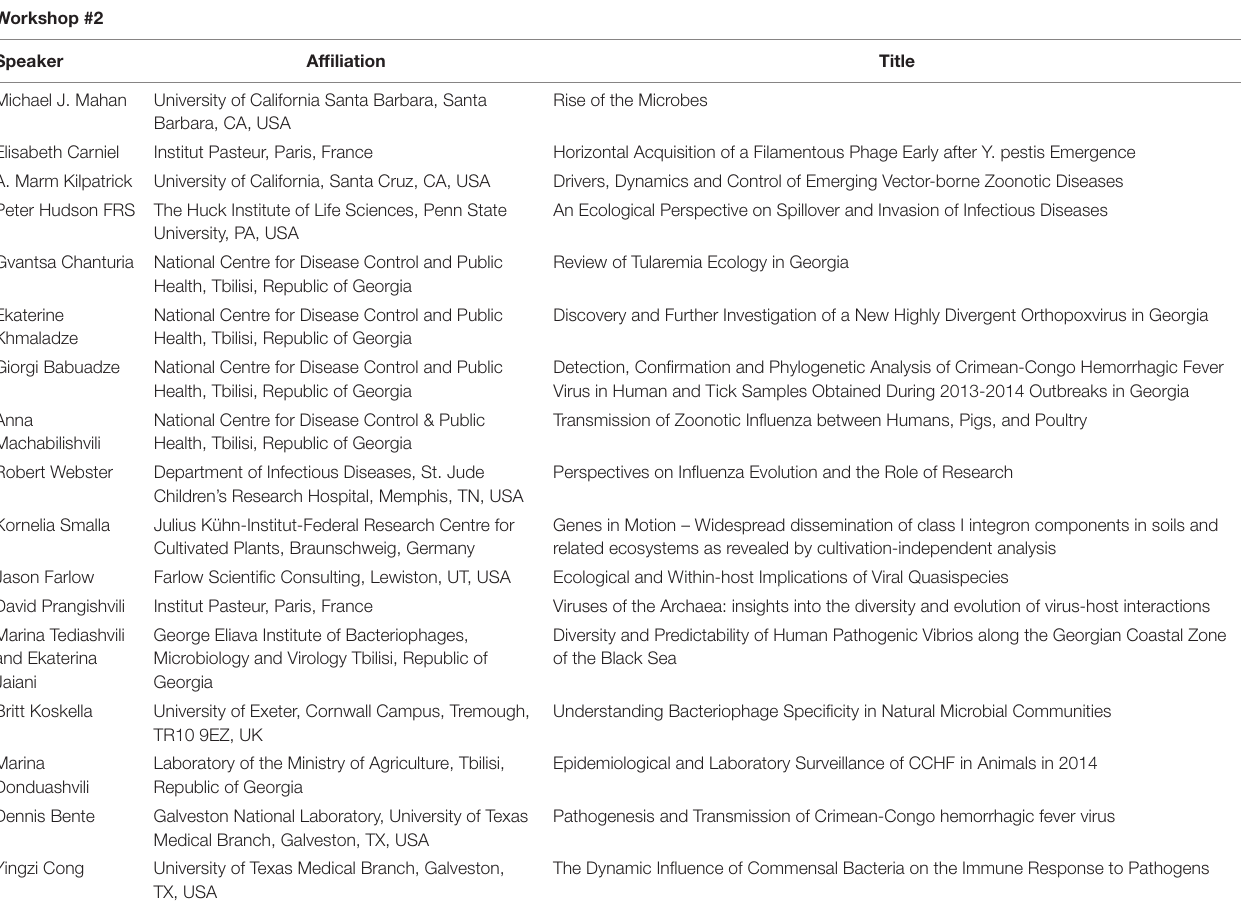
TABLe 3 | Microbial ecology of environmental Pathogens